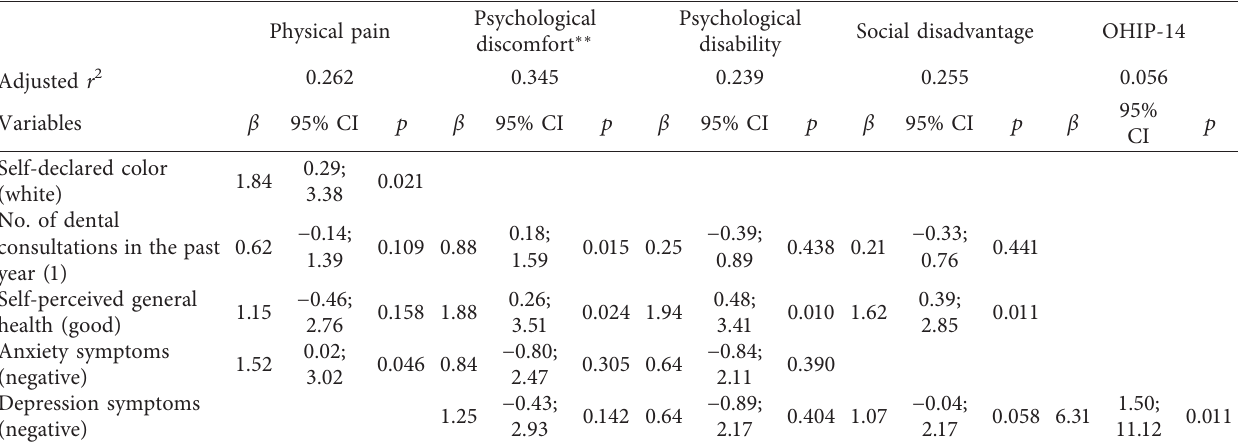
Table 5: Multiple linear regression model: factors associated with OHIP for women inmates in Juiz de Fora,